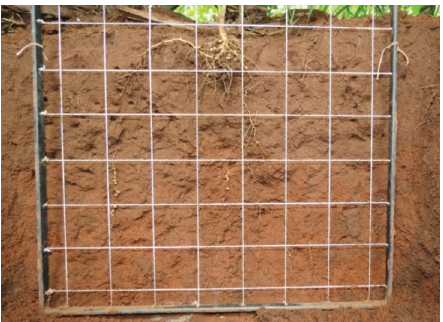
Figura 3. Distribuição das raízes de soja em perfil de 0,40 × 0,30 m e, em detalhe, quadrículas de 0,05 × 0,05 m utilizadas na medição do sistema radicular por meio da técnica de